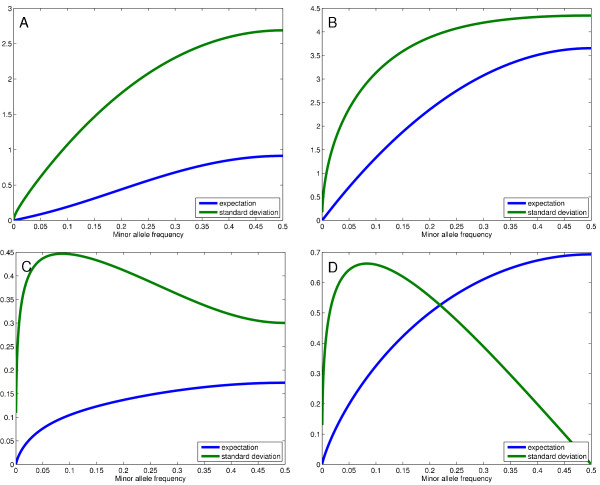
Log-evidence comparison. Expectation and standard deviation of random variable ΣIBD||NO IBD (A), ΩIBD||NO IBD (B), ΣNO IBD||IBD (C), and ΩNO IBD||IBD (D) as minor allele frequency varies (γ = 8).